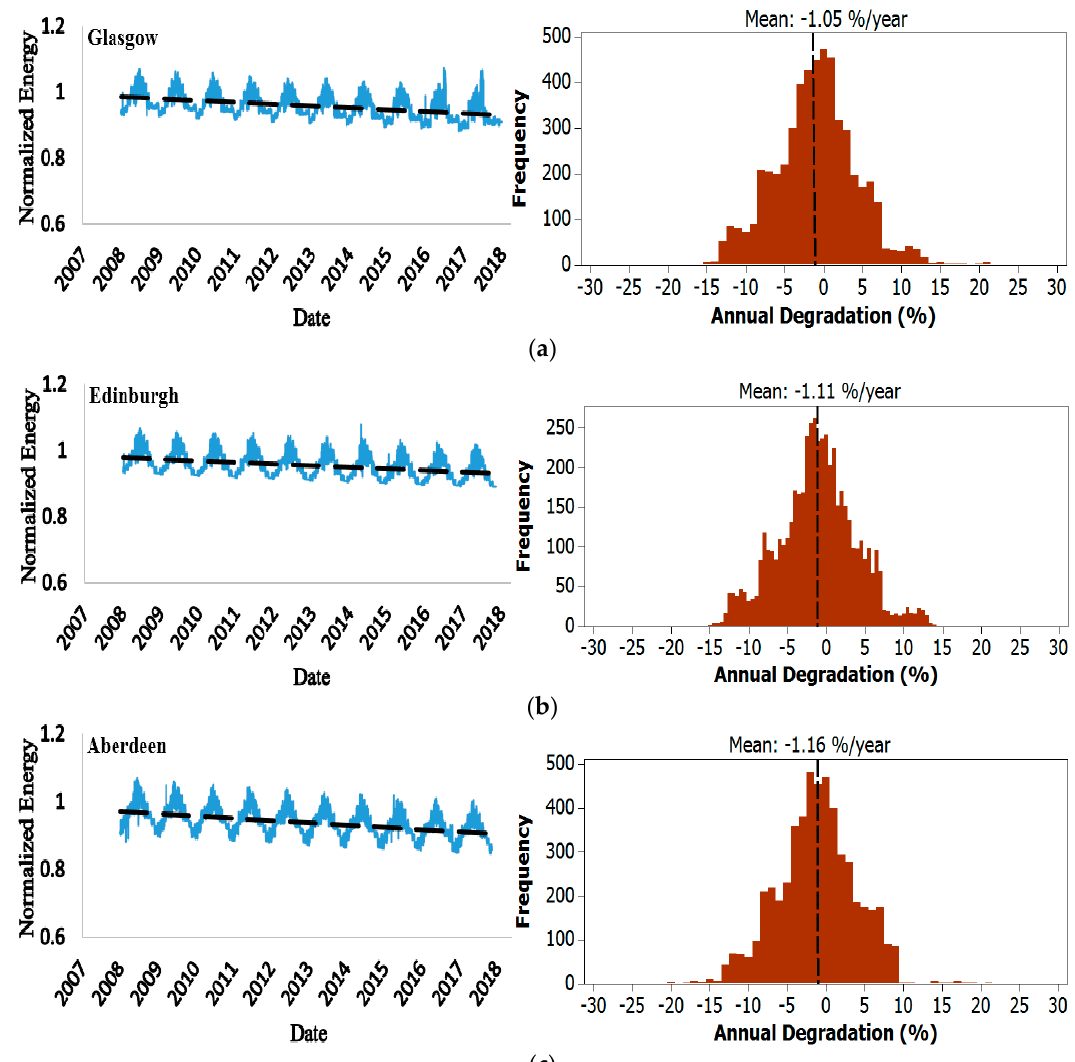
Figure 3. Normalized energy and annual degradation of the examined PV systems in the UK: ( a ) PV site A—Glasgow; ( b ) PV site B—Edinburgh; ( c ) PV site C—Aberdeen.